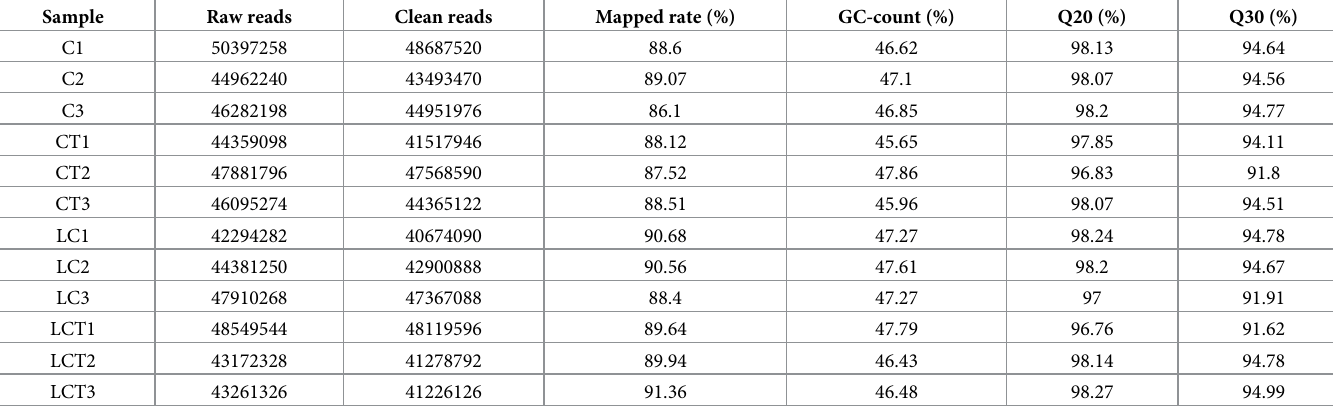
Table 2. Statistical analysis of RNA-seq reading